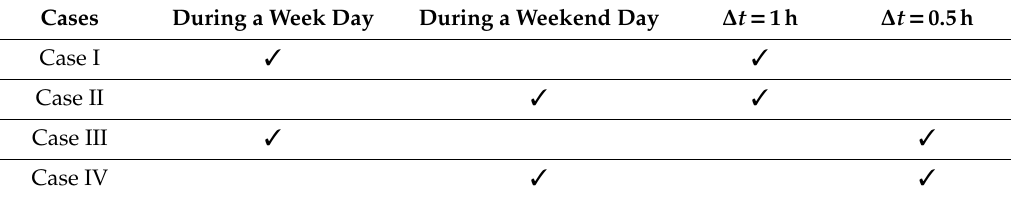
Table 2. EV charging coordination and offers of reserve services that the DERA performs for the test cases.